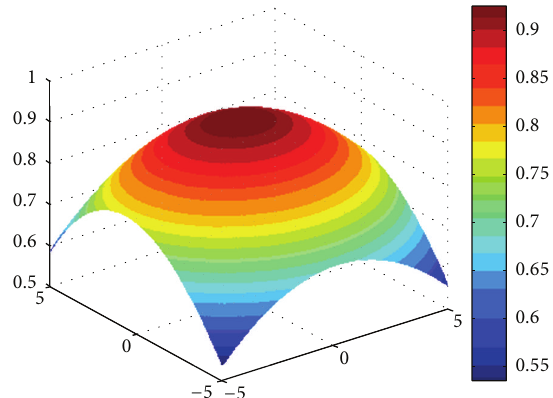
Figure 5: The result of three-surface